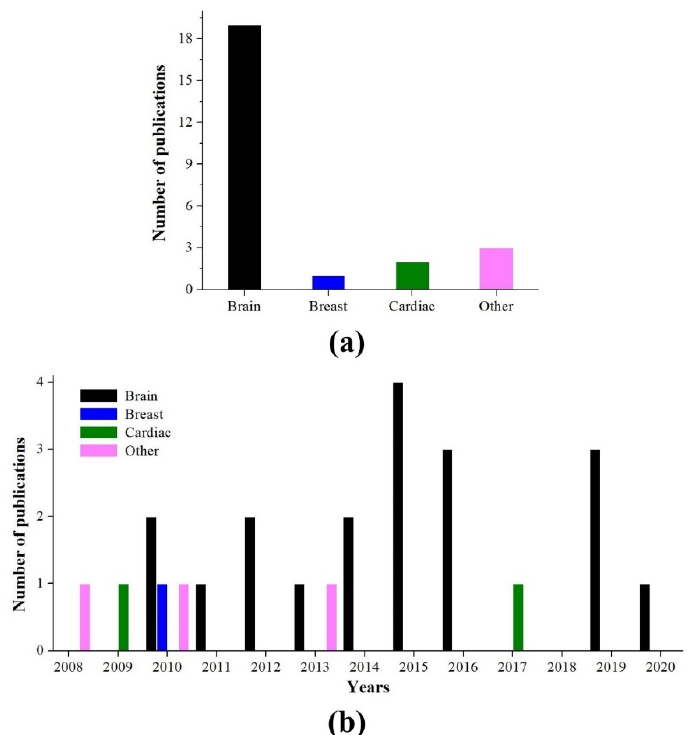
Figure 5. ( a ) Graph of the number of publications for various target organs of MR imaging scans using the NLM noise reduction algorithm. The final classification included 25 papers; of those, four major categories of techniques were investigated. ( b ) The total number of papers as a function of the publication year. Table 3. Characteristics for target organs of MR imaging from studies retrieved for systematic review.